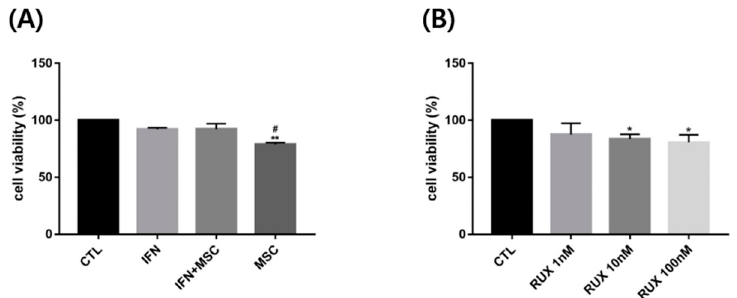
Figure 2. Cell viability of PBMCs from AA patients in response to treatment with hMSCs: ( A ) Co- culturing with hMSCs significantly decreased cell viability of PBMCs in AA patients compared to control and IFN- γ -treated group. ( B ) Ruxolitinib significantly suppressed the cell viability of PBMCs at concentrations above 10 nM. The data represent the means ± SEM, n = 3, statistically significant at * p < 0.05, ** p < 0.01 compared to control, and # p < 0.05 compared to the IFN- γ - treated group.